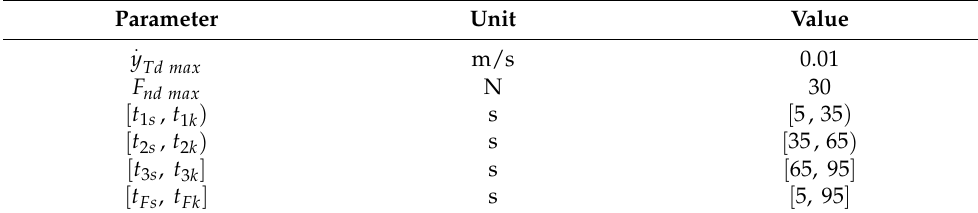
Table 2. Parameters of the set trajectory.